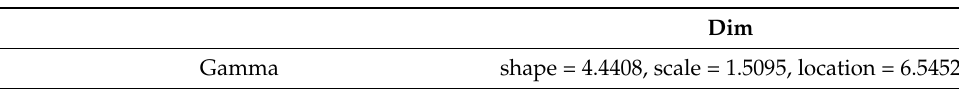
Table 5. MLEs of the model parameters for Dimension.